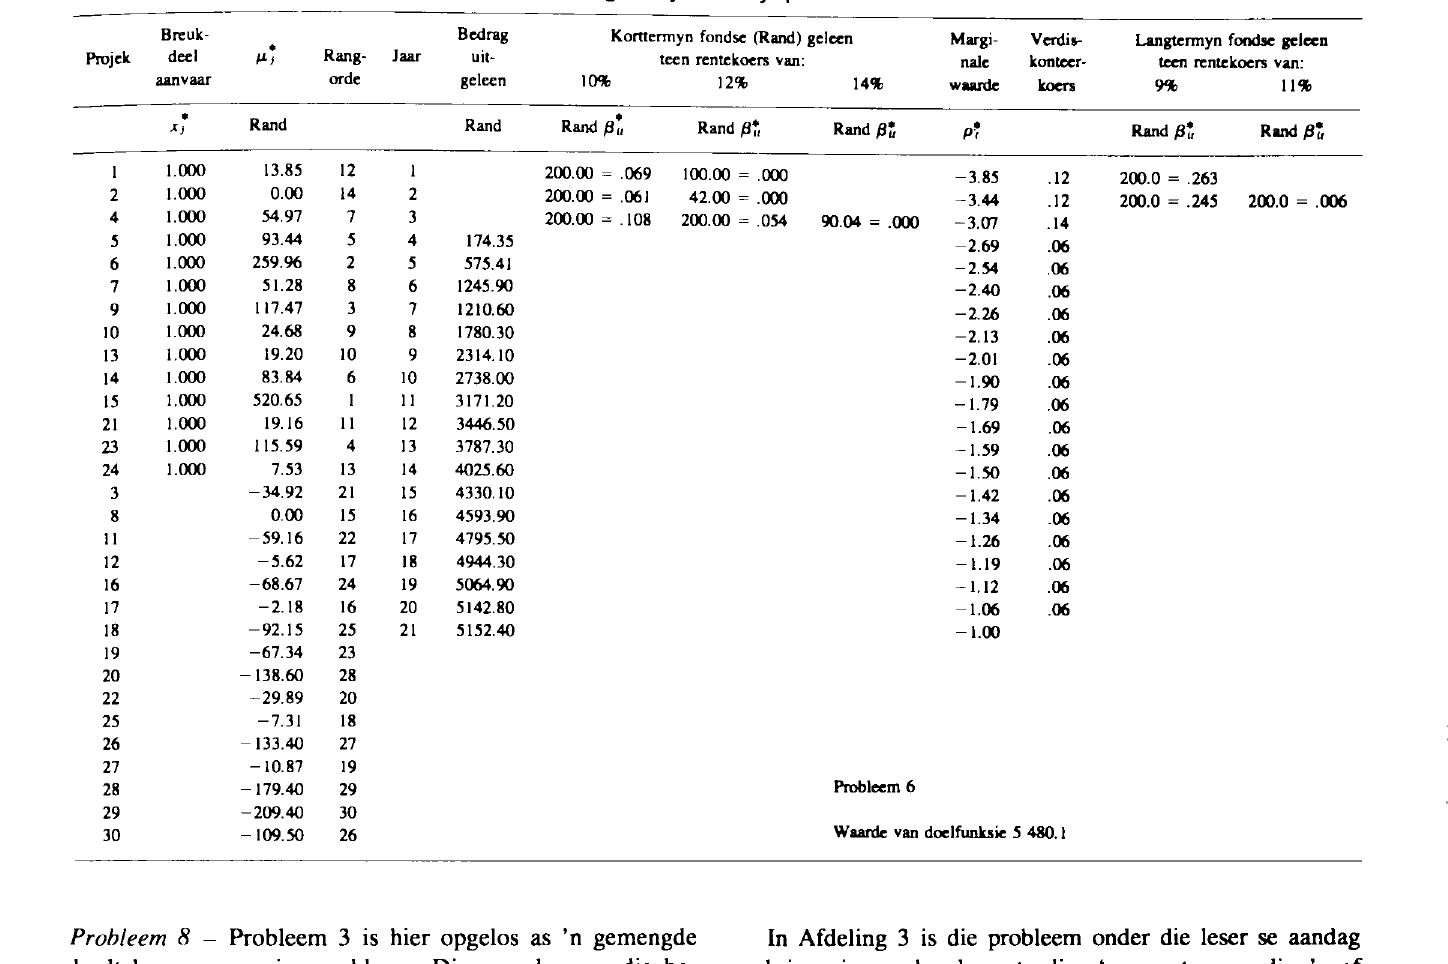
Tabel 4 Die basiese probleem uitgebrei soclat langtermyn finansiering gebruik kan word. Die hoofsom plus rente is alles terugbetaalbaar aan die einde van die langtermyn leentydperk